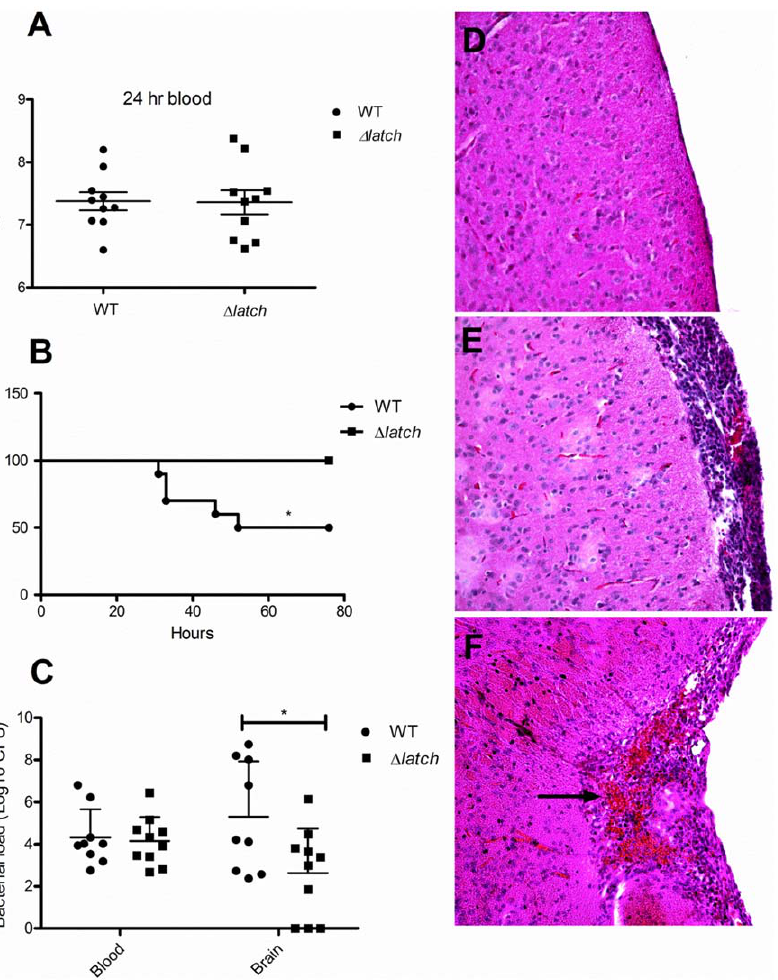
Figure 9. Impact of the latch-like domain on GBS virulence. Bacteria counts in the blood and brain of mice infected with GBS WT or D l atch bacteria, determined 24 h post infection (A) or at the time of death (C). The horizontal lines denote the median number of bacteria in each group of 10 mice. (B) Kaplan-Meier survival curves of CD-1 male mice following i.v. infection with GBS NCTC 10/84 or D latch strains. (n=10 per group). (D–F) Histopathology of representative brain tissues from mice infected with GBS D latch (D) and WT GBS (E, F). Note significant increase of meningeal thickness and neutrophil infiltration in WT infected brain tissue, but not in animals infected with the D latch variant.